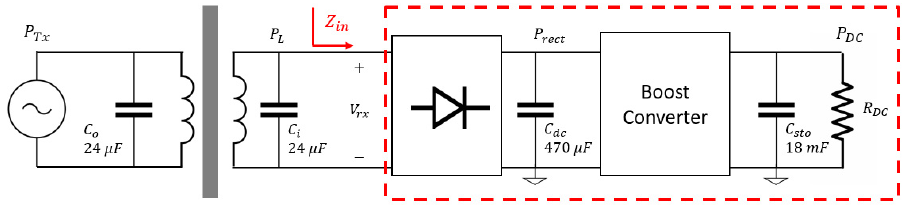
Figure 15. Complete schematic of harvesting subsystem.